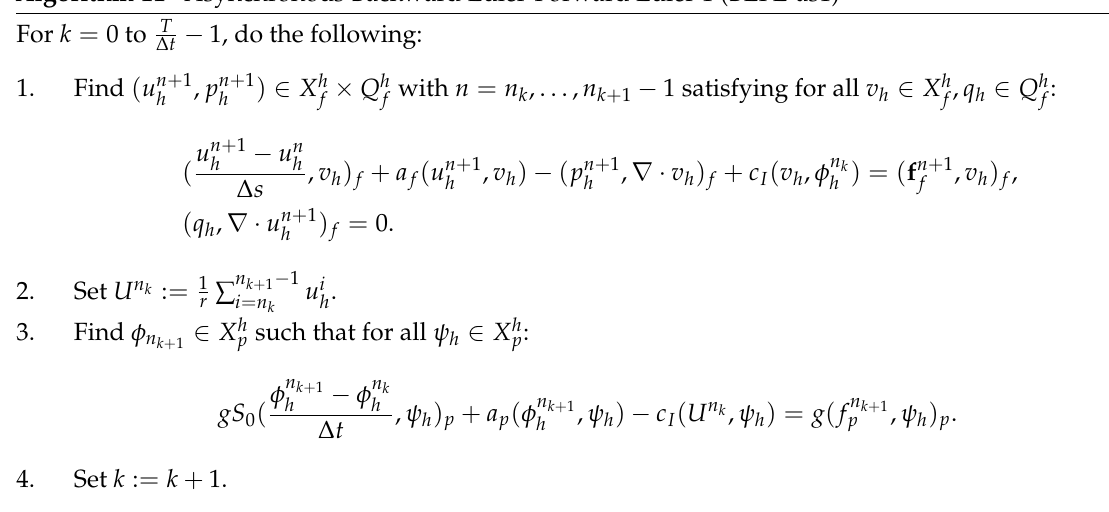
Algorithm 11 Asynchronous Backward Euler-Forward Euler 1 (BEFE-as1) − 1, do the For k = 0 to T ∆ t